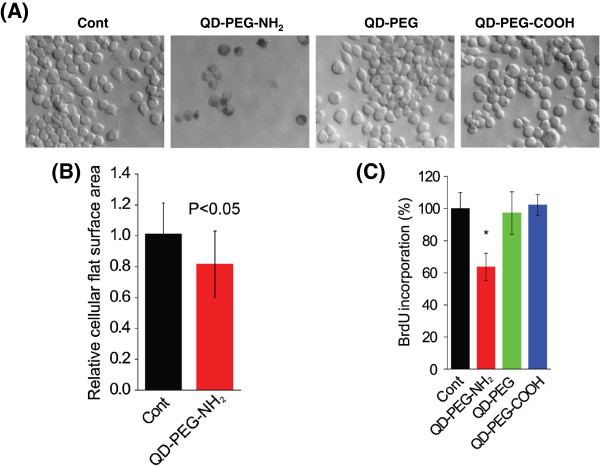
Biological influence of QDs on J774A.1 cells. (A) Bright field images of J774A.1 cells treated with QDs with different surface modifications at 47 μg/ml for 5 days (×40). (B) The bar graph represents the relative cellular flat surface area of J774A.1 cells treated with 47 μg/ml QDs coated with PEG-NH2 for 5 days (n = 50). (C) Cell proliferation was evaluated with the BrdU incorporation assay upon treatment with 47 μg/ml QDs with different surface modifications for 24 h (n = 6). Asterisk indicates P < 0.001.